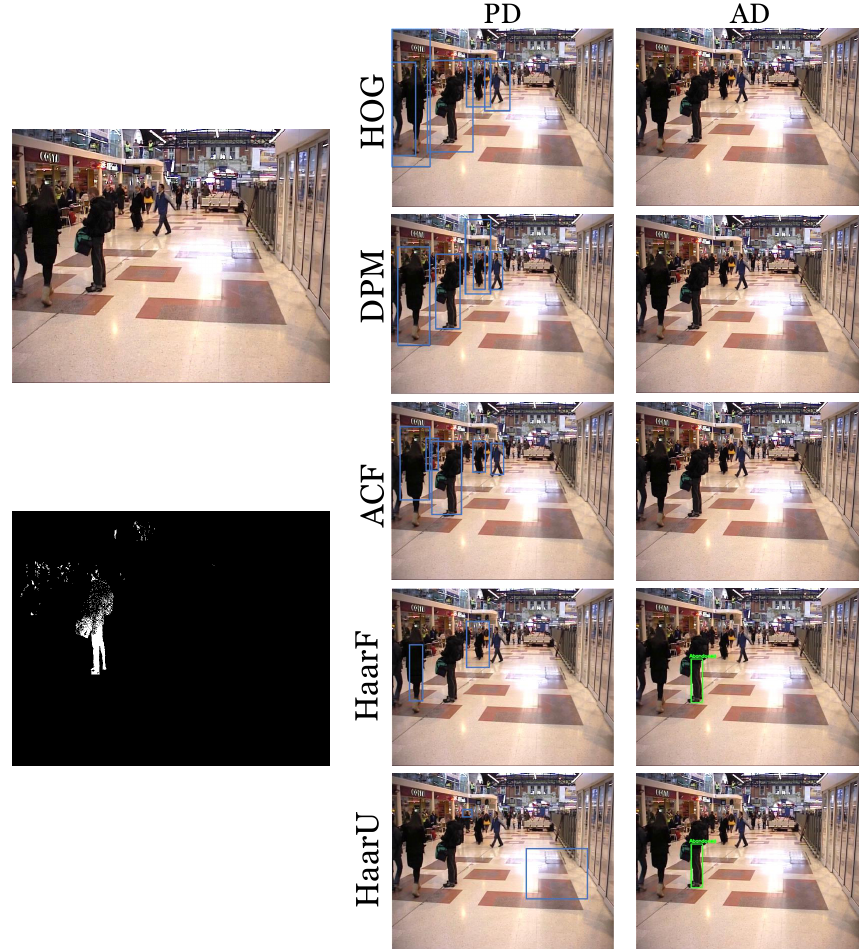
Figure 13. The first column shows the frame under consideration and its computed stationary foreground mask (DBM); the second column reports the visual results of the implemented people detector; and the third column presents the abandoned object discrimination of the system. It can be observed that the Haar-like feature classifier for full (HaarF) and upper body parts (HaarU) were not able to detect the standing stationary person; therefore, the system was mistakenly detecting him as an abandoned